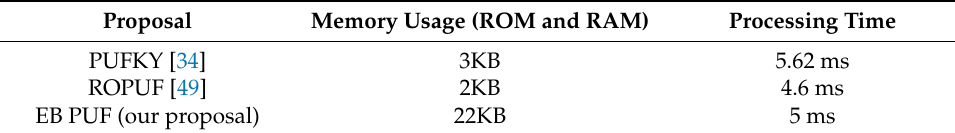
Table 3. Resource consumption. Comparison to previous